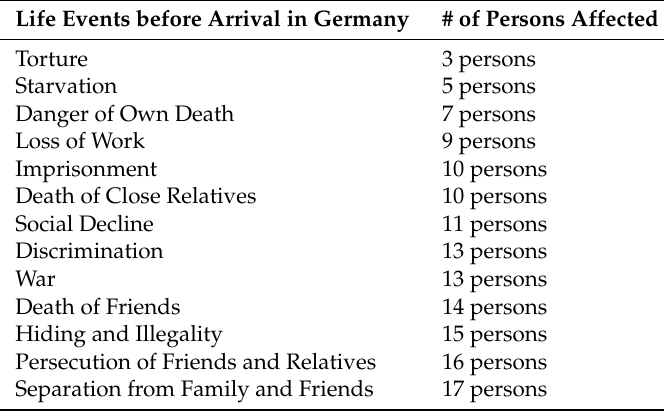
Table 1. Life events in home country and on the flight ( N = 20).